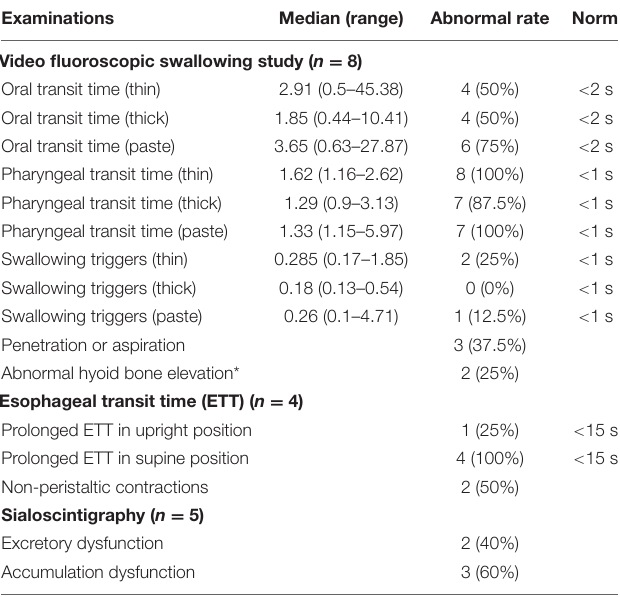
TABLE 3 | Examinations of dysphagia in the A97S